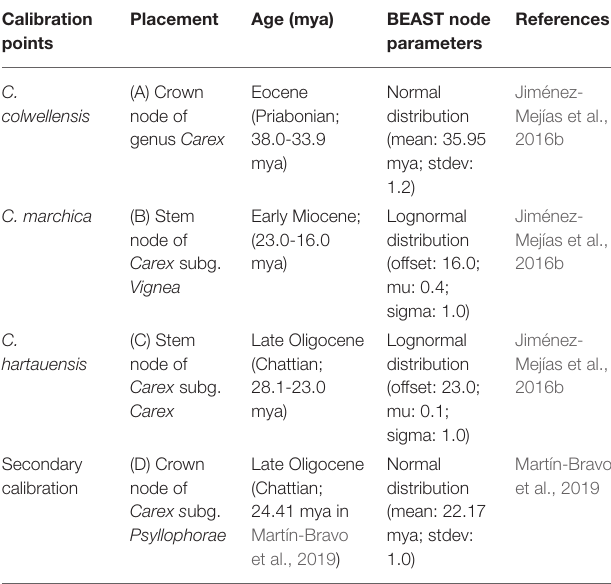
TABLE 2 | Three calibration points based on fossils and a secondary one were used to date the phylogenetic tree of Carex subg. Psyllophorae using